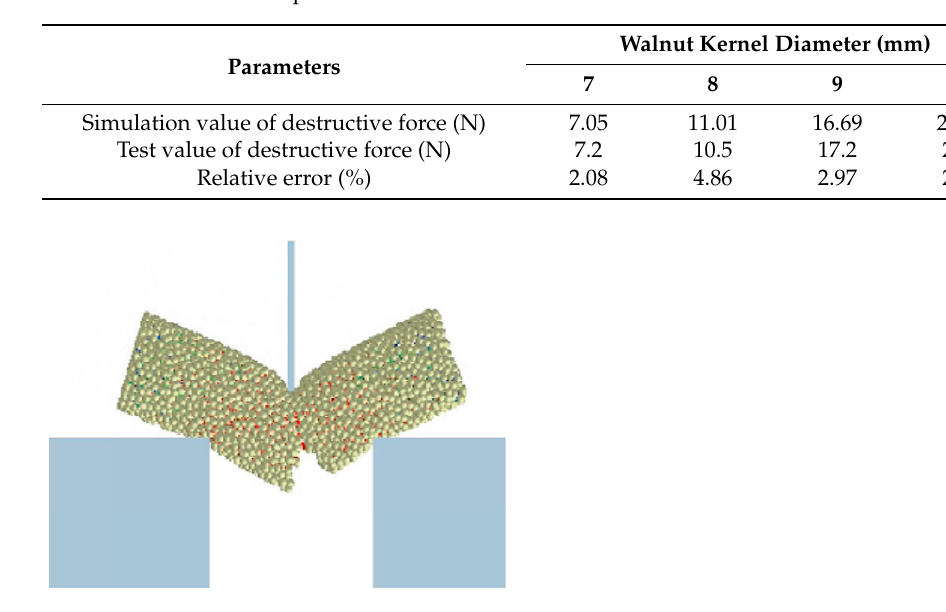
Figure 6. The bending test of the cylindrical samples used in the EDEM. Table 12. The simulation parameters of the walnut kernel used in the